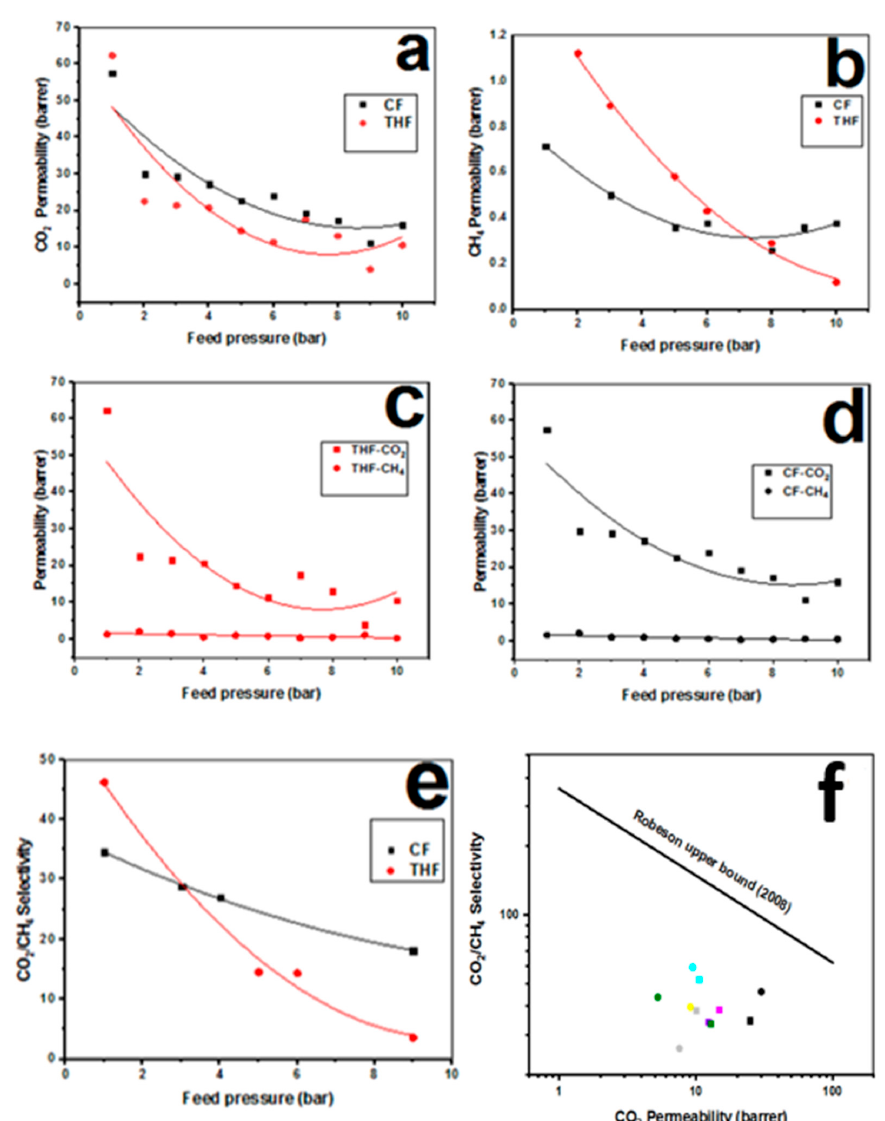
Figure 4. ( a ) CO2 permeabilitie s from THF and CF, ( b ) CH4 pe rme abilitie s from THF and CF, ( c ) permeabilities of CO2 and CH4 for THF, ( d ) permeabilitie s of CO2 and CH4 for CF, ( e ) CO2/CH4 selectivitie s for THF and CF, and ( f ) selectivity value s of CO 2/CH4 for THF (Symbols • , • , • , • and • refer to 1, 4, 7, 8, and 10 bar, respectively) and CF (Symbols (cid:4) , (cid:4) , (cid:4) , (cid:4) , (cid:4) and (cid:4) refer to 1, 5, 6, 7, 8, and 10 bar, respectively) in Robeson upper bound Regression